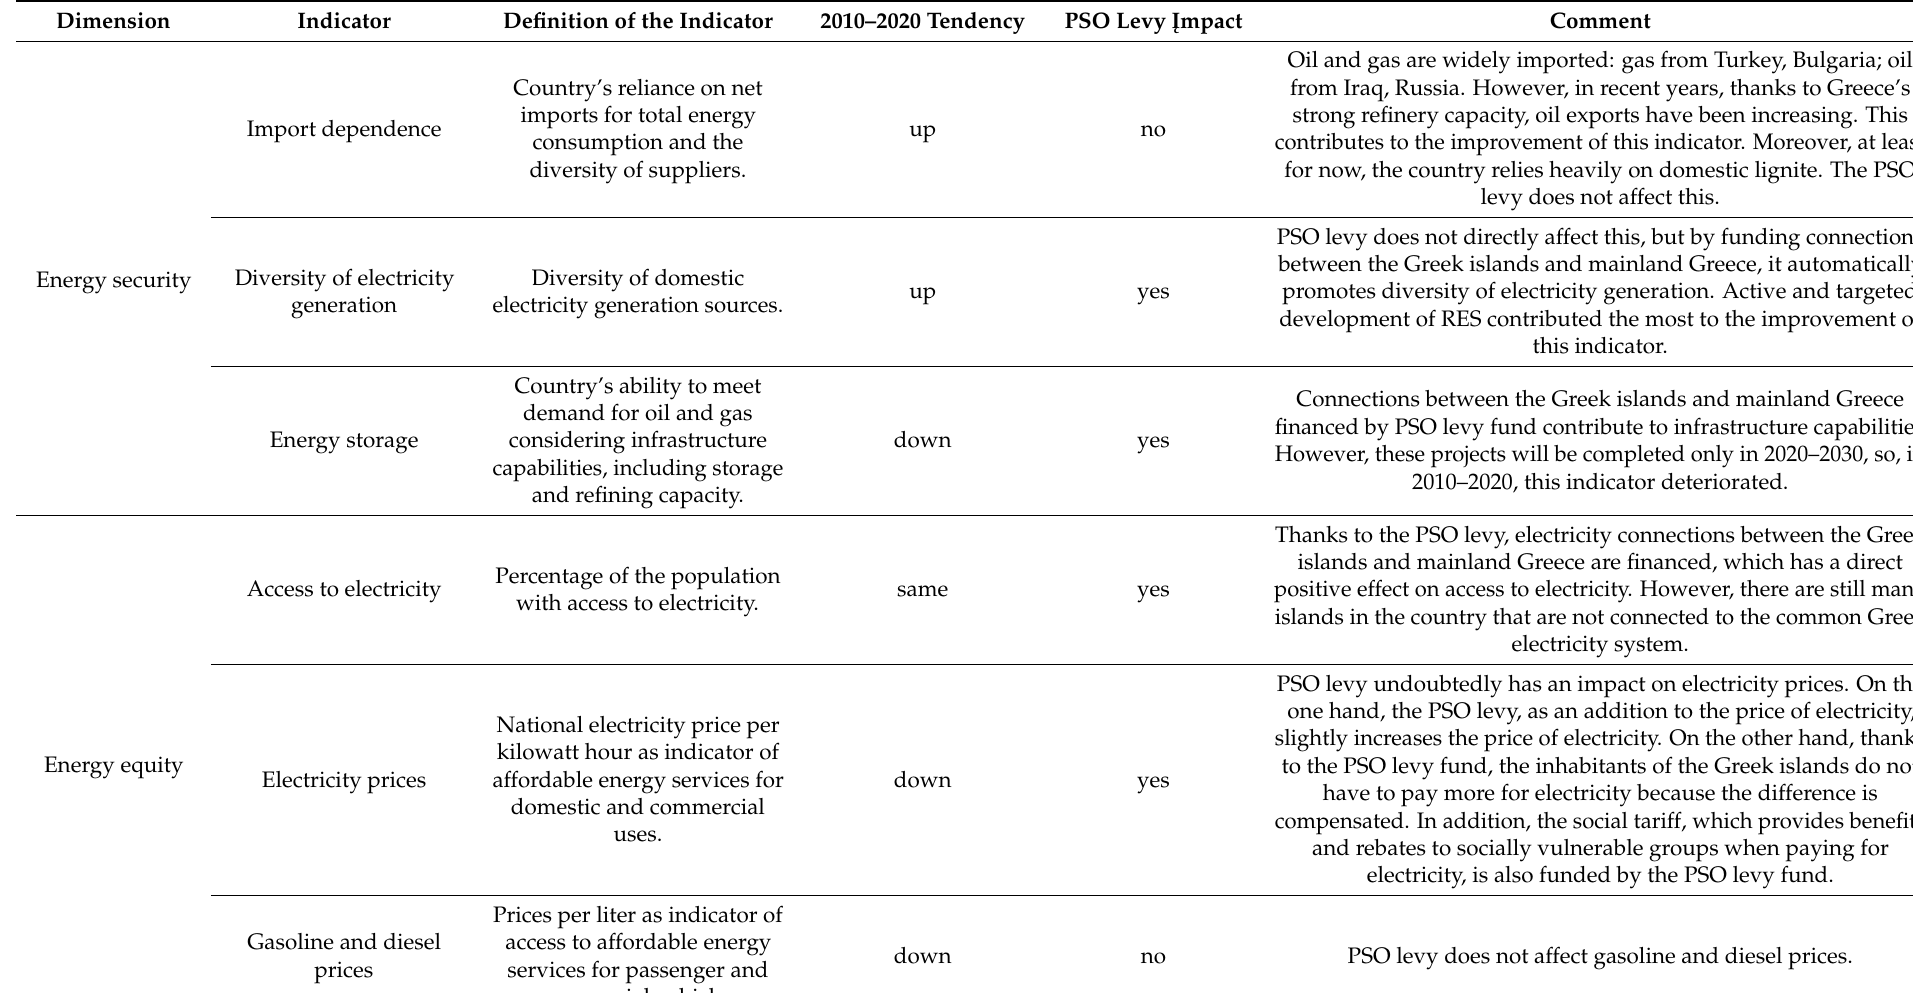
Table 4. PSO levy impact on Energy Trilemma Index for Greece (designed by the authors, based on